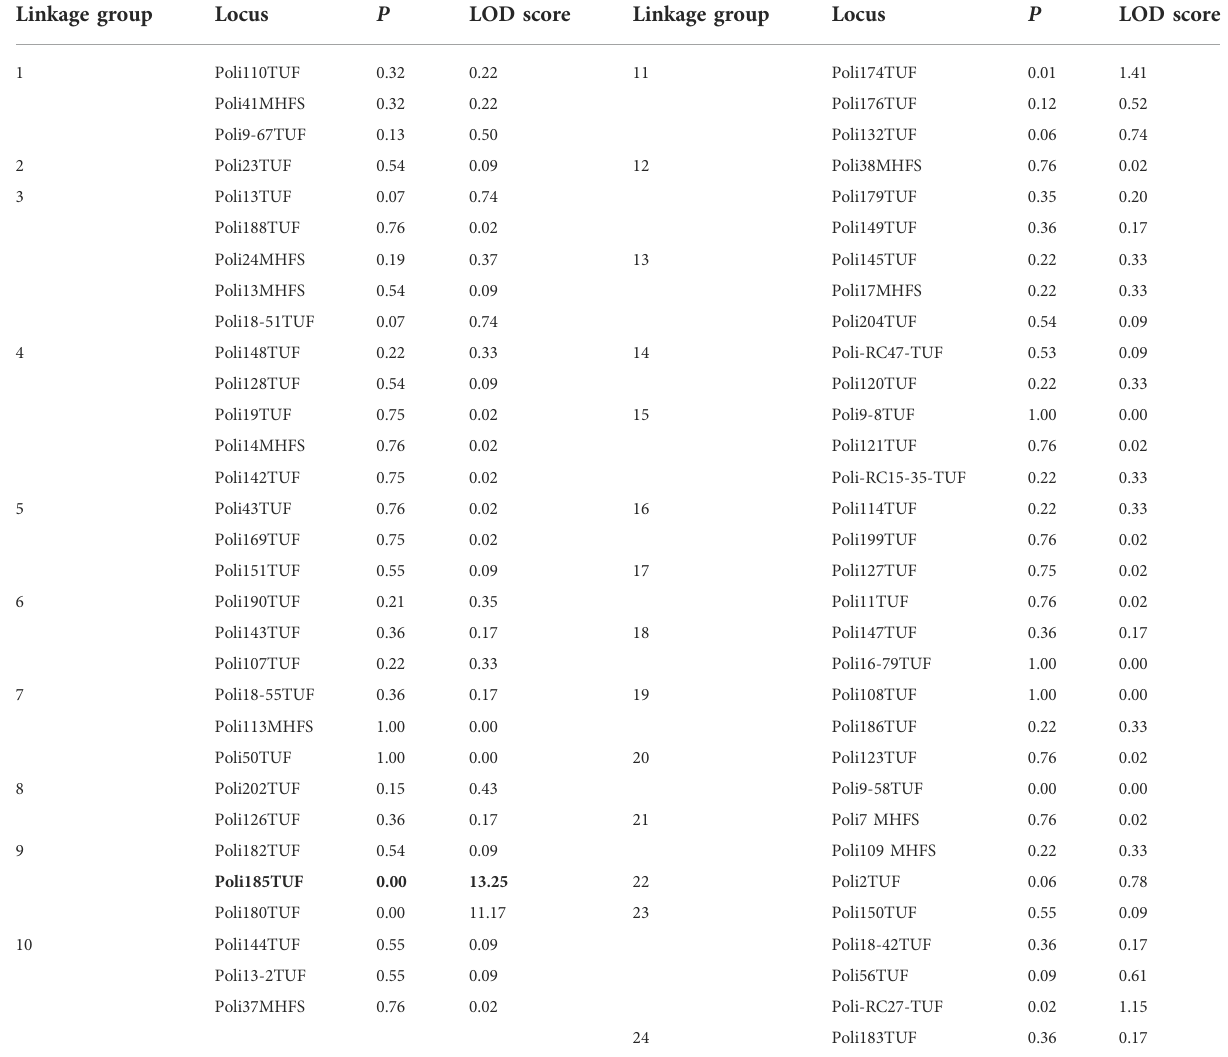
TABLE 1 Segregation of paternally inherited alleles of 63 microsatellite markers in 44 individuals (22 males and 22 females) of family A. The marker in bold represent the sex-determining locus. Linkage